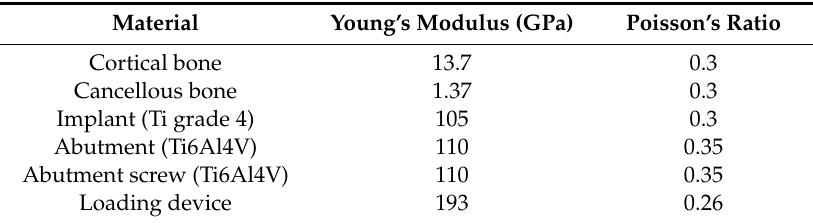
Table 2. Material properties adopted in our